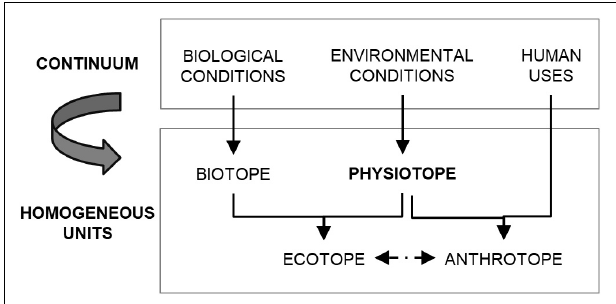
FIGURE 1 | Conceptual framework for scaling the continuum range of environmental, biological and human conditions into homogeneous units in complex nature-human